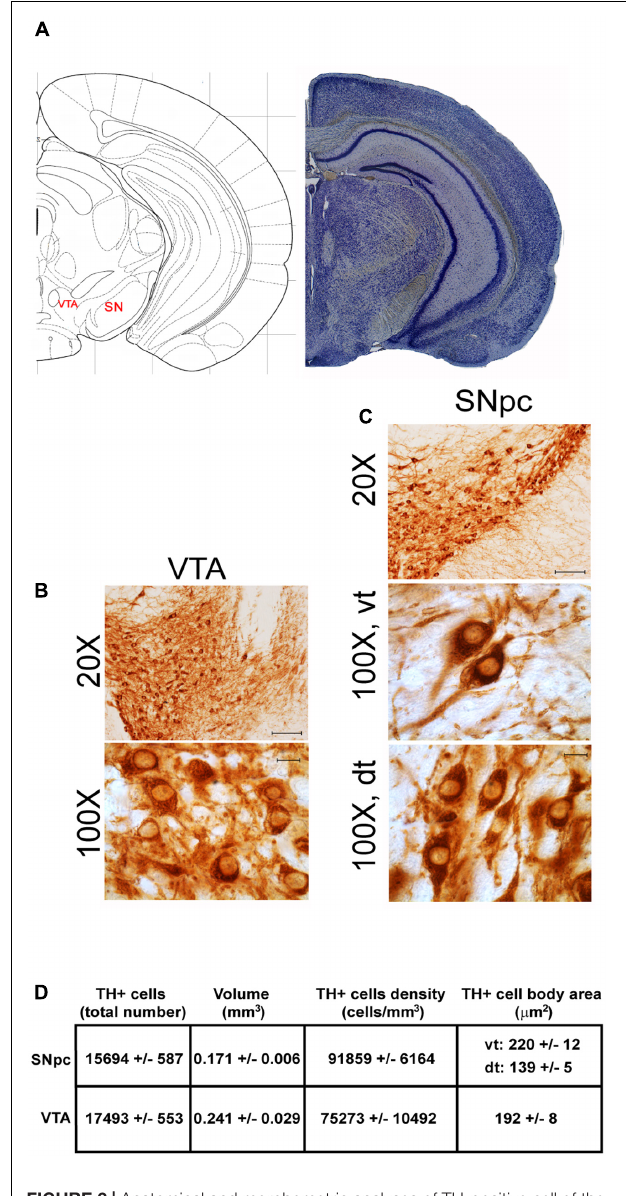
FIGURE 2 | Anatomical and morphometric analyses of TH-positive cell of the VTA and SNpc catecholamine nuclei. (A) Nissl staining of the mouse brain at the Bregma level –3.02 (Paxinos and Franklin, 2001) showing the anatomical localization of the VTA and SNpc. (B , C) Representative images of TH immunoreactive cells of the VTA and SN. Images at higher magnification (100X) show the morphological features of TH-positive cells of the VTA and the dorsal (dt) and ventral (vt) tier of the SNpc. Scale bar: 100 µ m for 20X and 10 µ m for 100X. The corresponding morphometric analyses are shown in (D) . Values are means ±